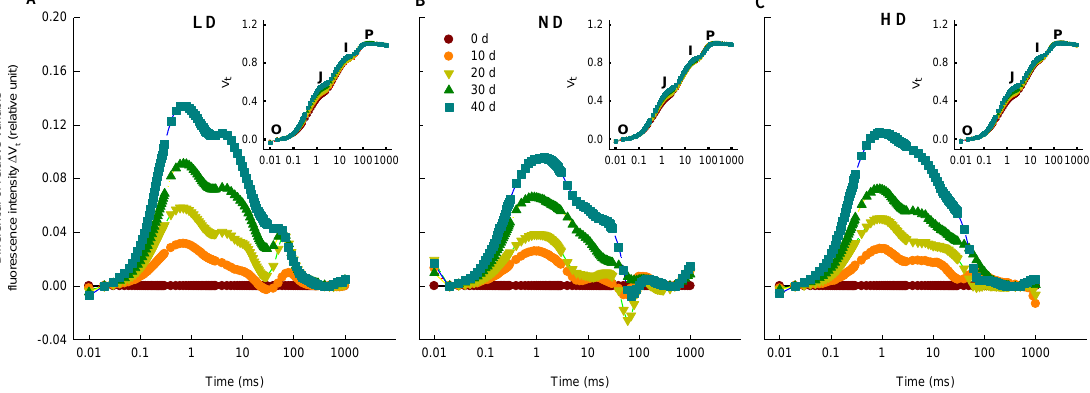
Figure 3. Chlorophyll a fluorescence (ChlF) induction transient curves of maize leaves. ( A – C ) Effects of planting density (( A ), low density, LD; ( B ), normal density, ND; ( C ), high density, HD) on differential plots of relative ChlF ( ∆ V t = (F t − F o )/(F m − F o ) − V t,0d ) in the leaves of maize at 0, 10, 20, 30, and 40 d after anthesis. For ∆ V t analysis, the fluorescence of leaves at 0 d after anthesis was used as a reference and set to 0. For the insert plot in ( A – C ), the chlorophyll a fluorescence (ChlF) transient OJIP kinetics curves, O, J, I, and P, represent the fluorescence intensity at 20 µ s, 2 ms, 30 ms, and 500 ms, respectively. Values are means ( n =